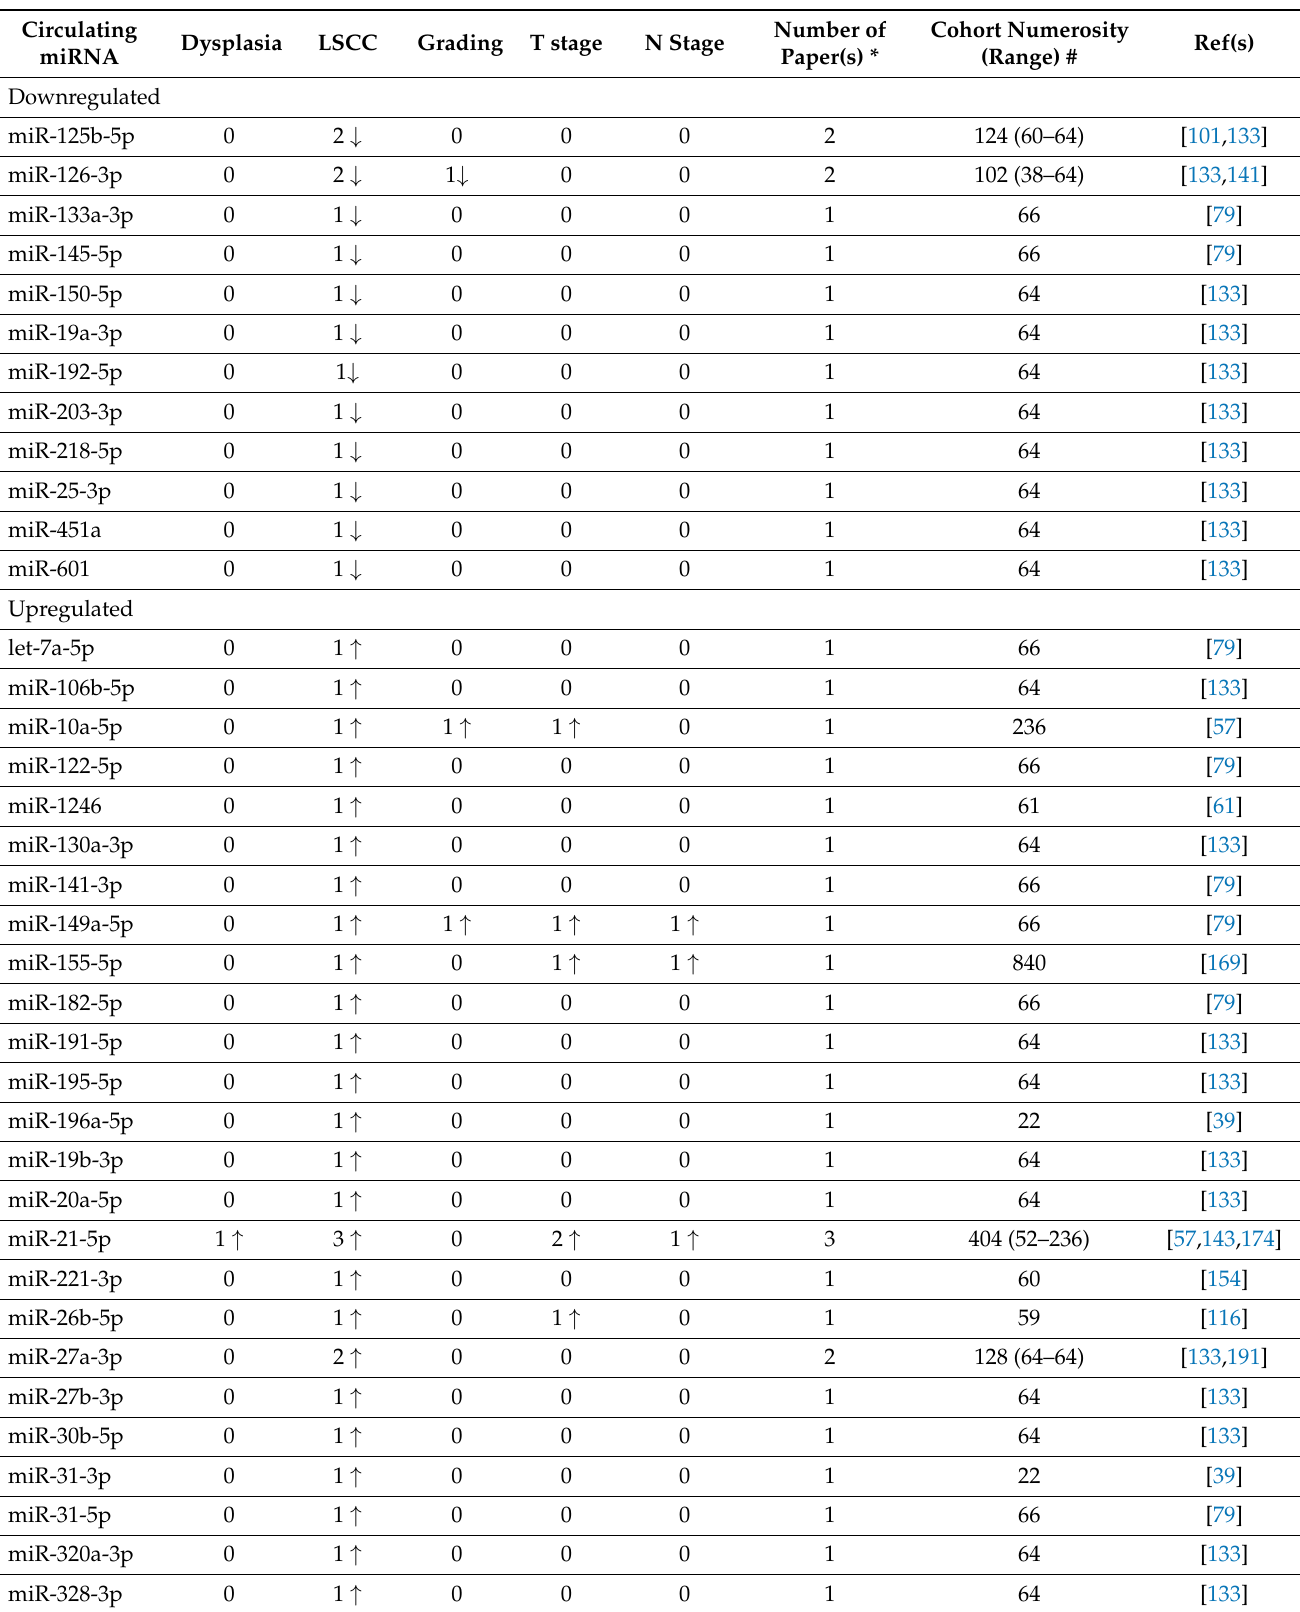
Table 3. Circulating miRNAs associated with diagnostic features in